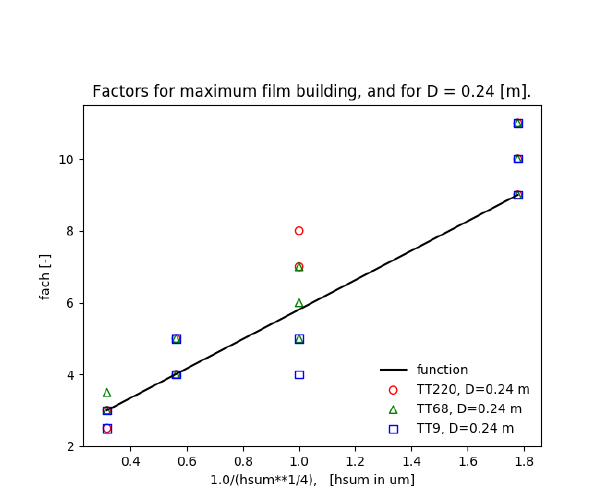
Figure 5: The film factors which gave maximum film for D = 0 . 24 m. The developed function is also